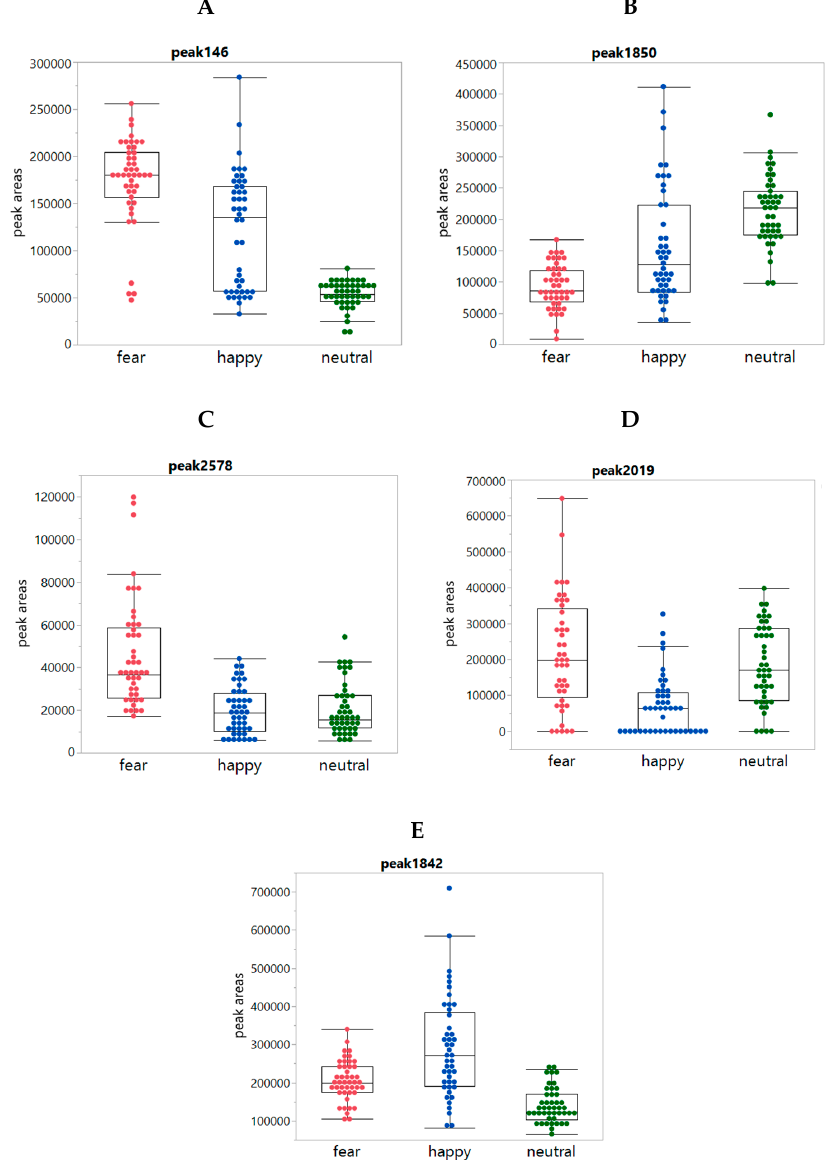
Figure 4. Box plots showing individual peaks per condition class: Panels ( A – E ) show the boxplots of the peaks 146, 1850, 2578, 2019, and 1842, respectively, per condition for each of the 24 panelists as observed in underarm sweat both left and right (so 48 datapoints for each of the three conditions in each